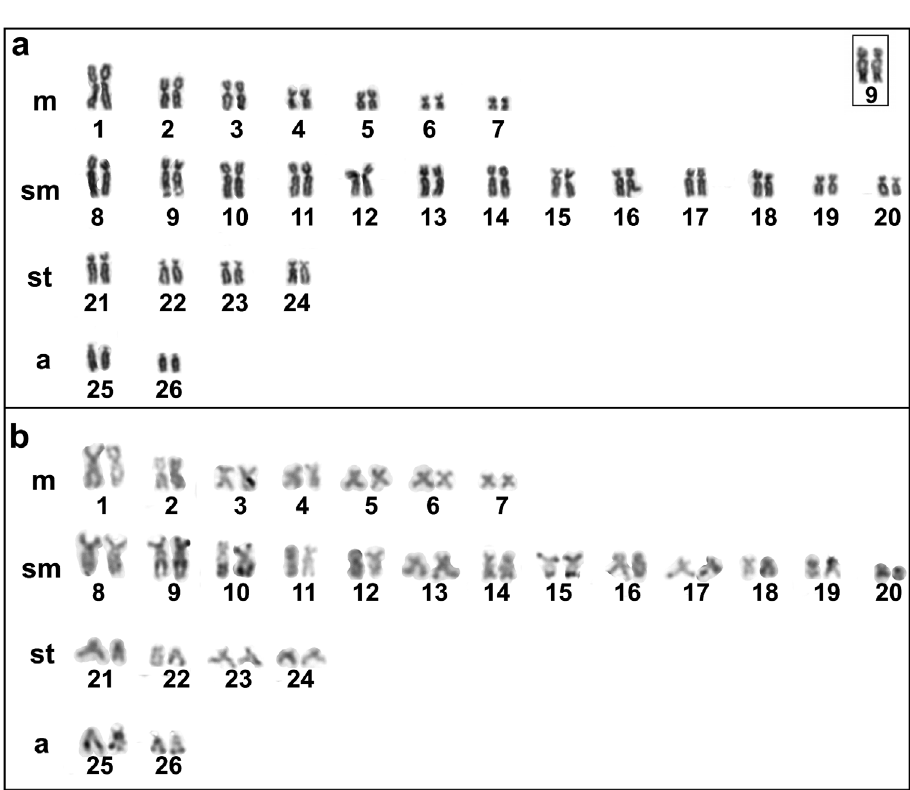
Figure 2. Karyotypes stained with Giemsa ( a ) and C-banding ( b ) of Pterygoplichthys anisitsi from Água Boa stream. Box: pair 9, bearing the